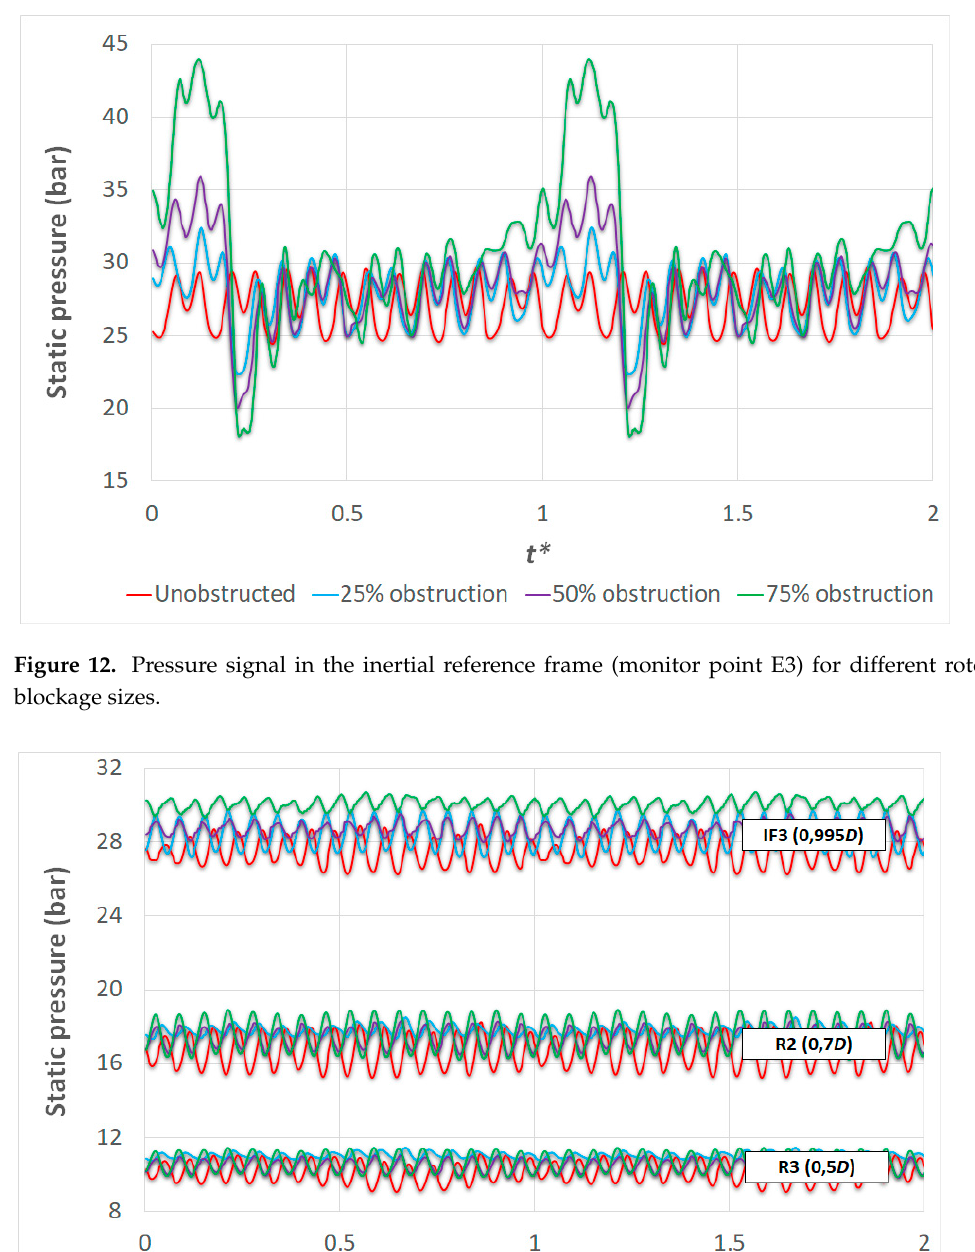
Figure 11. Relative velocity vector plot near the blockage for a 25% obstructed rotor.